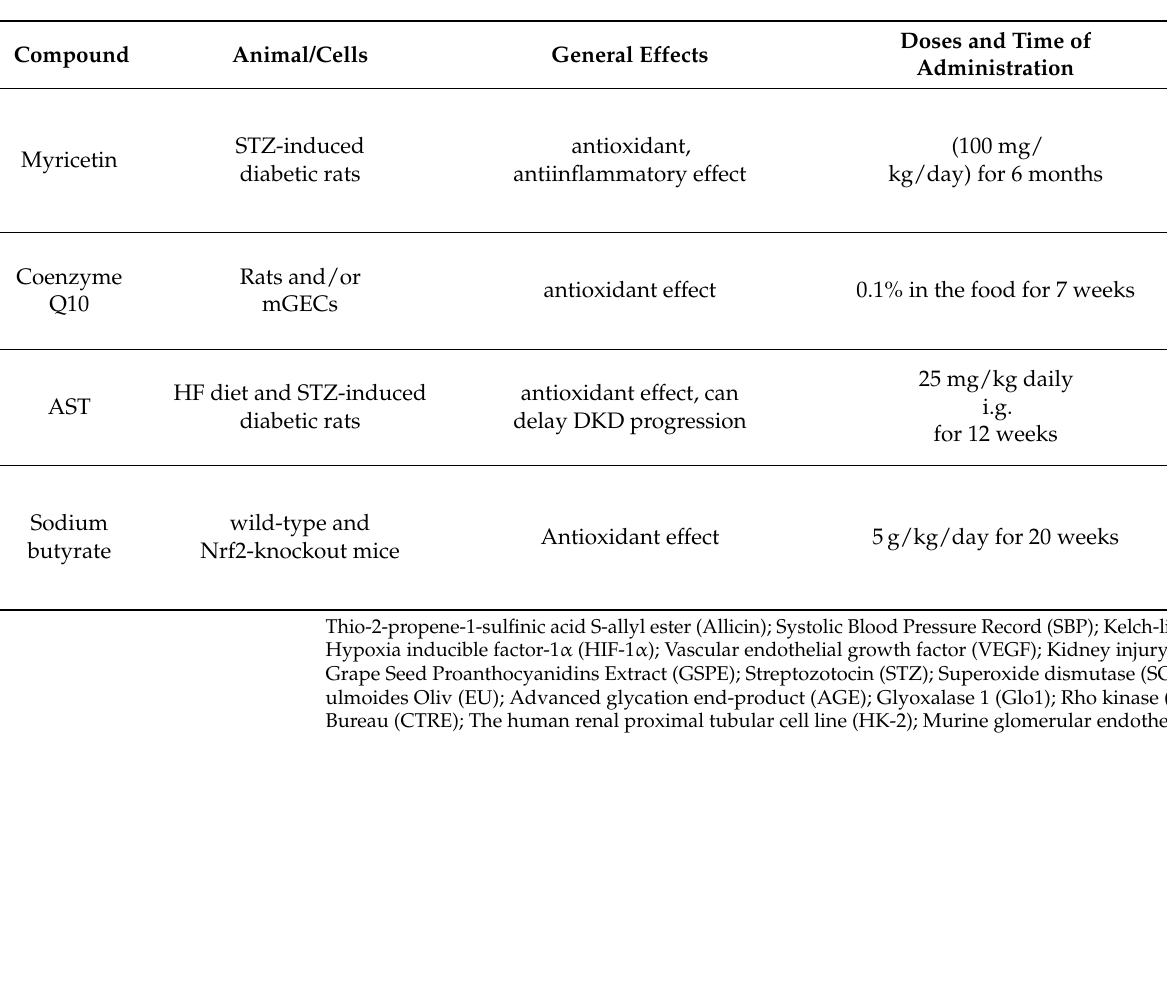
fibrosis, and oxidative damage and enhanced the